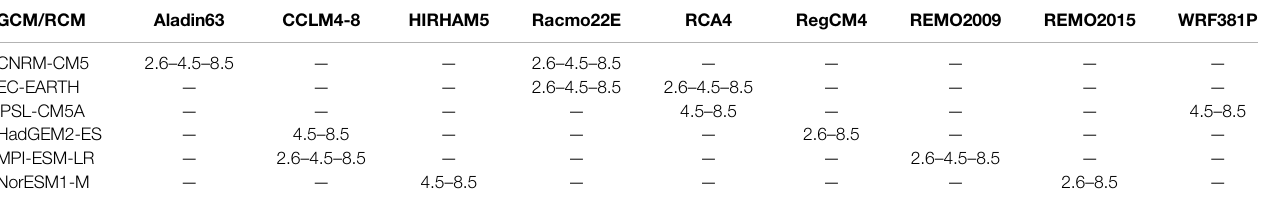
TABLE 1 | Availability of climate projections. The numbers (2.6, 4.5 and 8.5) refer to the RCPs used by the GCM (rows)/RCM (columns) pairs. “ - ” indicates the absence of data. Adapted from Lemaitre-Basset et al.